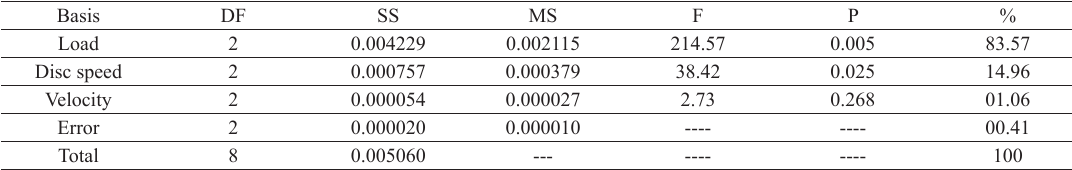
Table 2. Variance analysis for wear